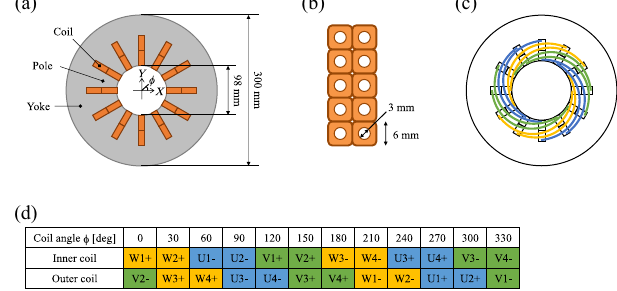
FIG. 2. Basic design of DW-SCM. (a) Cross-section of DW-SCM, (b) coil configuration, (c) coil connection at the coil-end region, (d) coil distribution table.